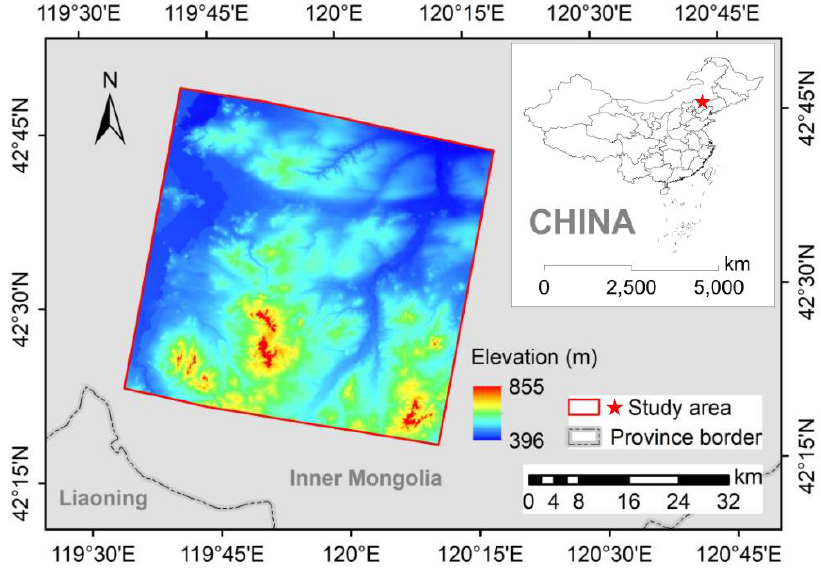
Figure 1. Location and elevation of the study area.